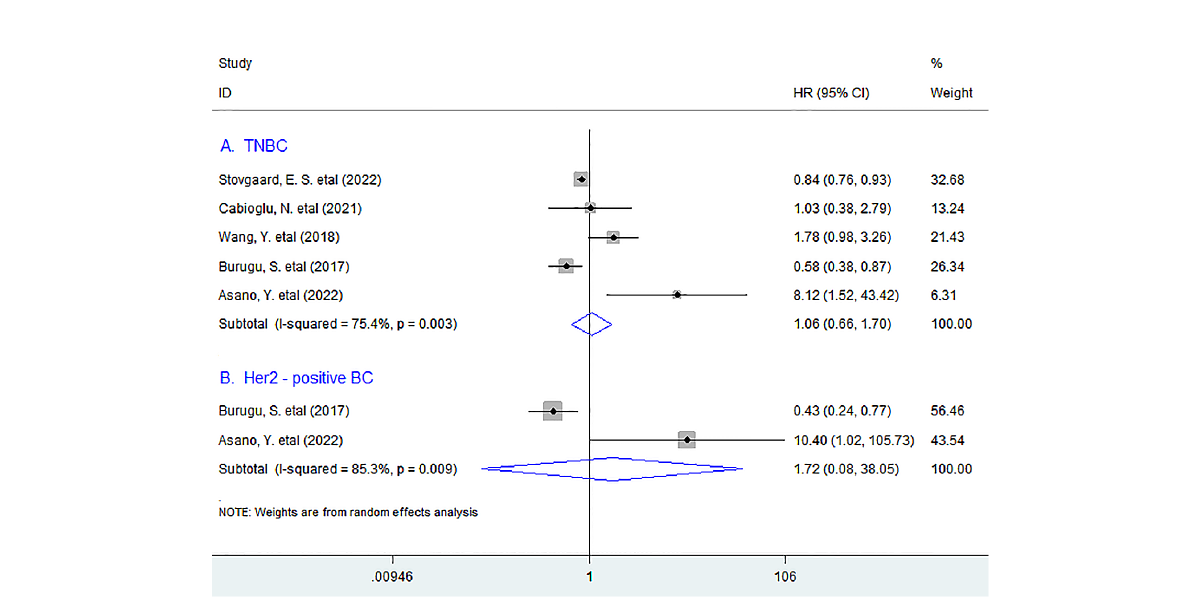
FIGURE 5 Strati fi ed analyses describing HRs of the association between the LAG-3 + tumor-in fi ltrating lymphocytes and DFS in TNBC and Her2-positive breast cancer. TNBC, triple-negative breast